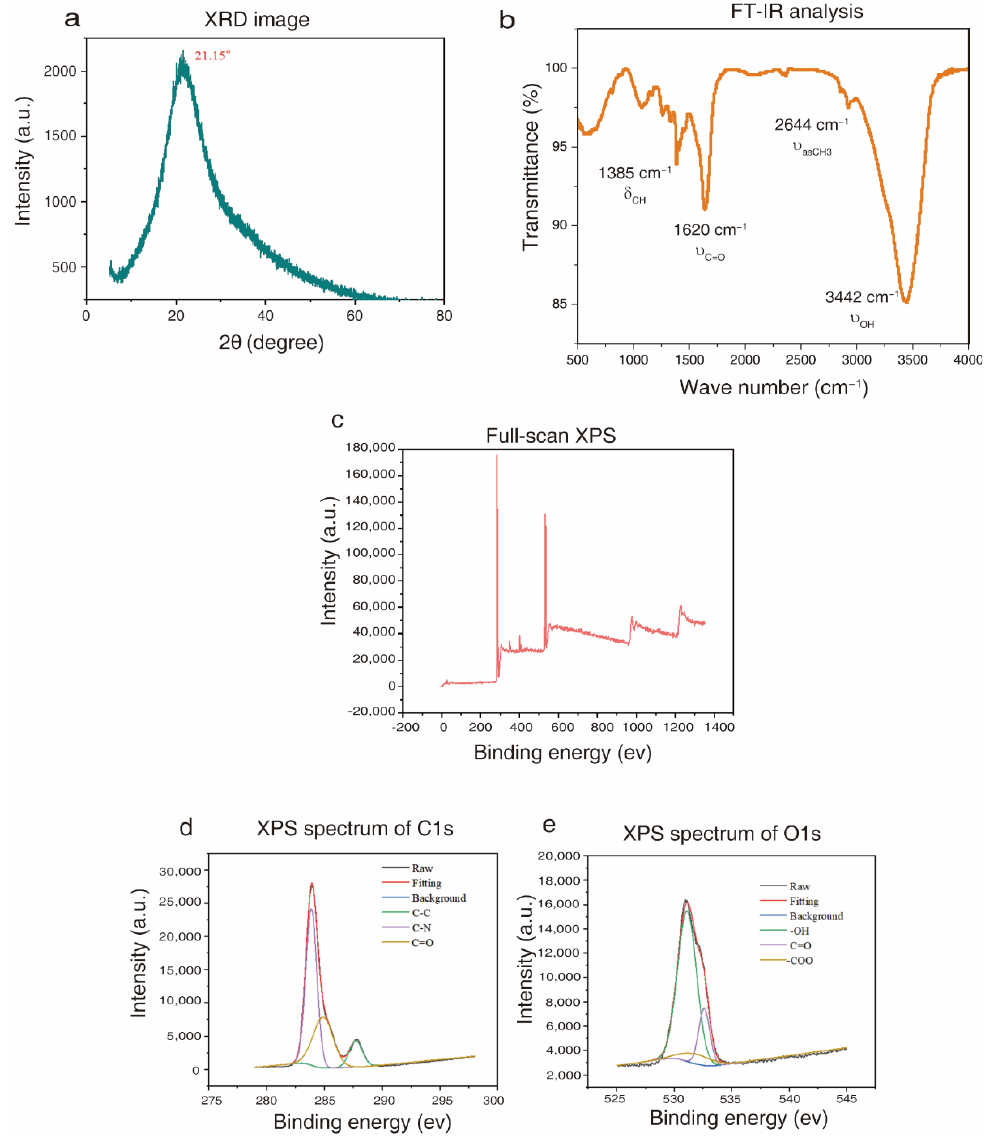
Figure 3. Functional groups of CQDs prepared from chicken bones. ( a ) XRD image of CQDs. ( b ) FT - IR analysis of CQDs. ( c ) Full - scan XPS spectrum of CQDs. ( d ) High - resolution XPS spectrum of C1s. IR analysis of CQDs. ( c ) Full-scan XPS spectrum of CQDs. ( d ) High-resolution XPS spectrum of C1s. ( e ) High-resolution XPS spectrum of O1s. ( e ) High-resolution XPS spectrum of